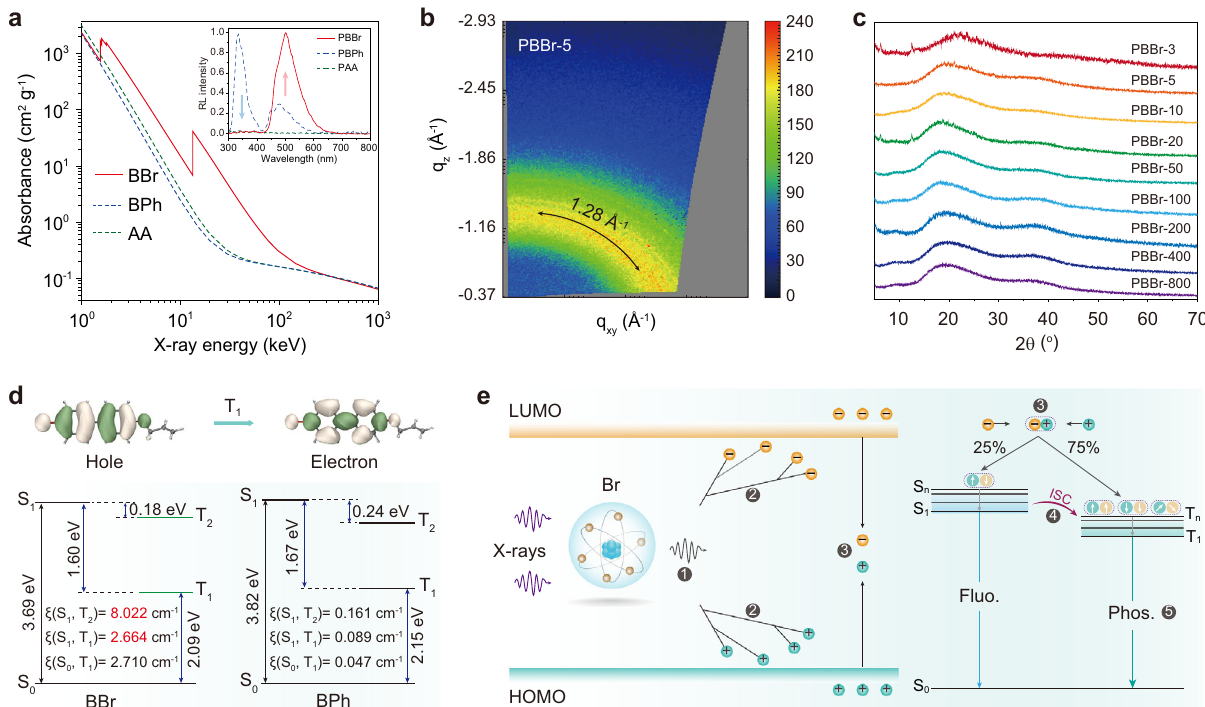
Fig. 3 Mechanism of phosphorescent scintillation from organic copolymers under X-ray irradiation. a X-ray absorption spectra of the BBr, BPh, and AA monomers. The insert shows the normalized radioluminescence (RL) intensity of the PBBr, PBBh, and PAA polymers at a dose rate of 278 μ Gys − 1 . b WAXS pattern of PBBr-5 polymer fi lm. c PXRD patterns of the copolymers from PBBr-3 to PBBr-800. d Natural transition orbitals (NTOs) for the lowest triplet state of BBr, and calculated excitation energies and spin-orbit coupling (SOC) constants ( ξ ) of the BBr and BPh monomers. e Proposed mechanism of radioluminescence for amorphous copolymers. After X-ray irradiation, the electron in the inner shells is excited by high-energy X-ray photons and ejected out of the Br atom. Then, the high-energy electrons generate lots of secondary electrons by interacting with other atoms in the polymer. The generated electrons and holes are rapidly thermally dissipated and gradually accumulate at the lowest unoccupied molecular orbital (LUMO) and highest occupied molecular orbital (HOMO) of the organic phosphors, respectively. Eventually, the electrons and holes recombine to form excited states, generating singlet and triplet excitons in a ratio of 1:3, which produces fl uorescence (Fluo.) and phosphorescence (Phos.) via the radiative decay processes,